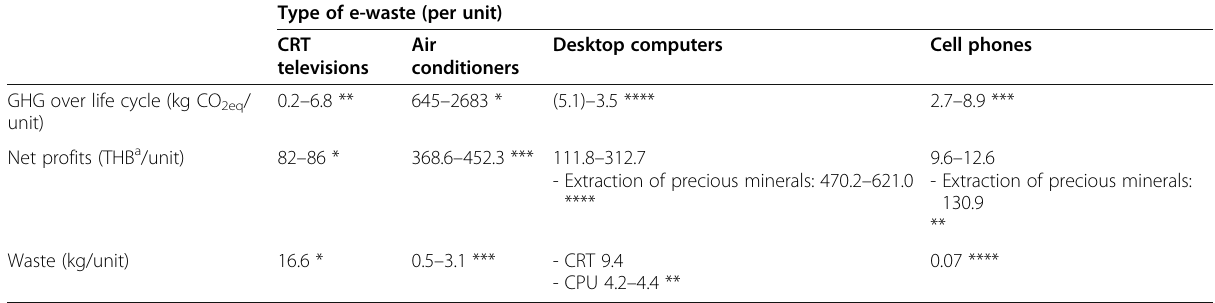
Table 6 Life cycle GHG and LCC assessment results for each type of e-waste from households to dismantling locations and recycling firms